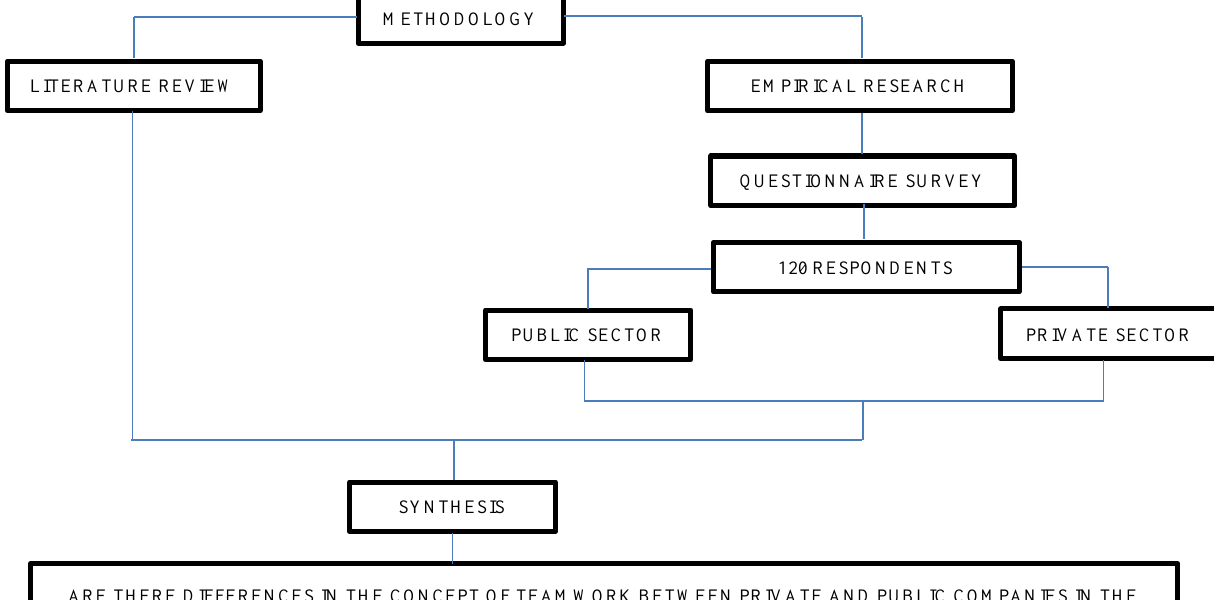
Figure 1. Methodology